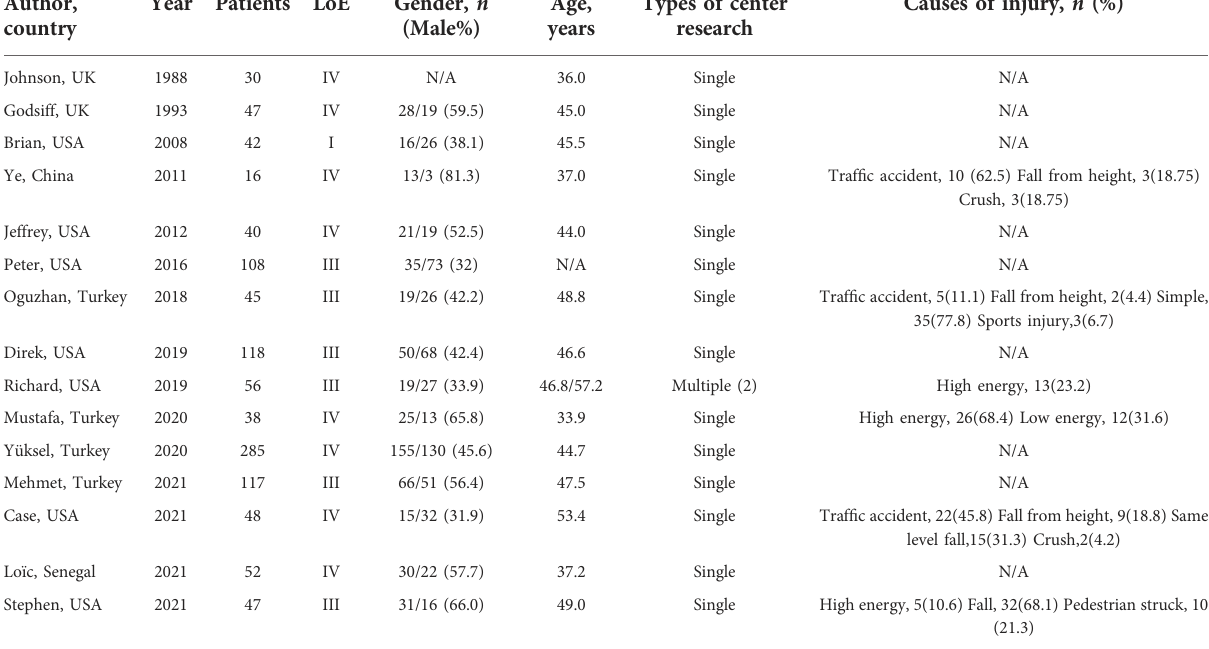
TABLE 2 Demographics of the 15 included